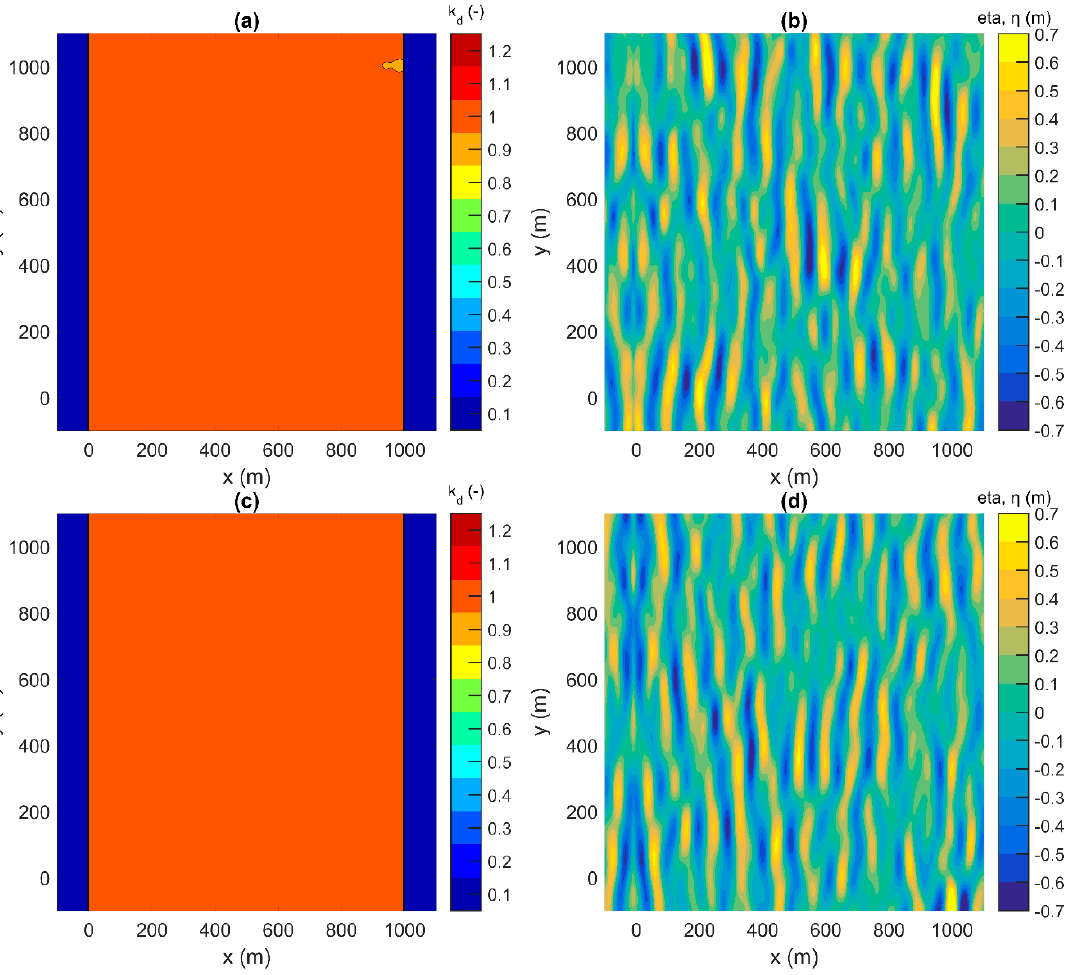
Figure 10. Disturbance coefficient, k d , and water surface elevation, η , in the inner computational domain at t = 7000 s for irregular short crested waves with H s = 1 m, T p = 12 s, θ = 0 ◦ , and σ θ = 10 ◦ synthesized by using the Miles method ( a , b ) and the Sand and Mynett method ( c , d ).